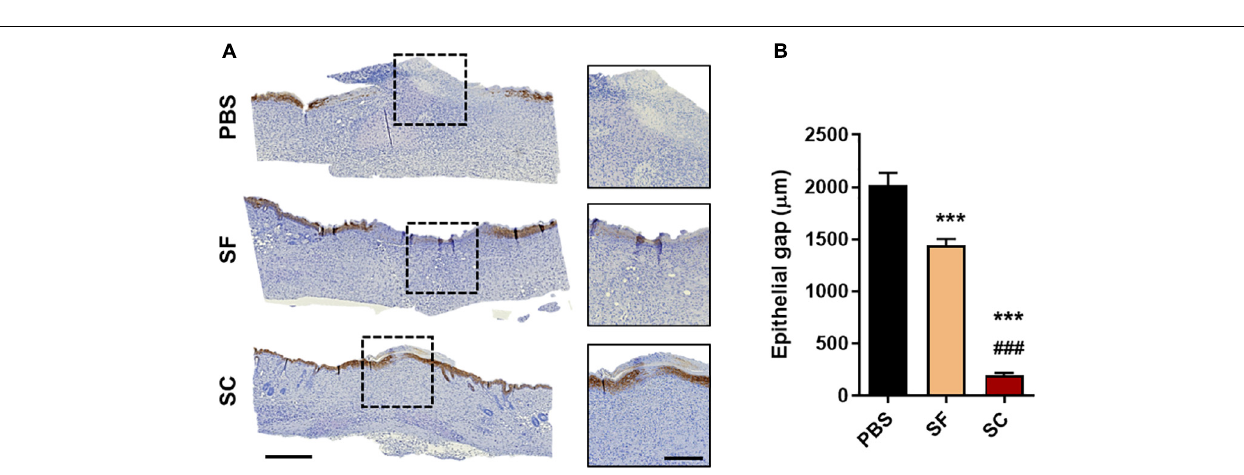
FIGURE 3 | Immunohistochemical staining of cytokeratin-10 on day 14. (A) Representative microscopy images (Scale bar = 500 µ m in low magnified images and 200 µ m in high magnified images) and (B) the gap between the regenerated epithelial cells (*** ### p < 0.001).